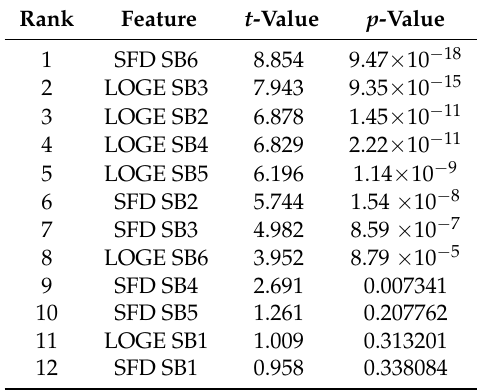
Table 6. Student’s t -test results, t -value and p -value. SFD, signal fractional dimension; LOGE, log-energy.